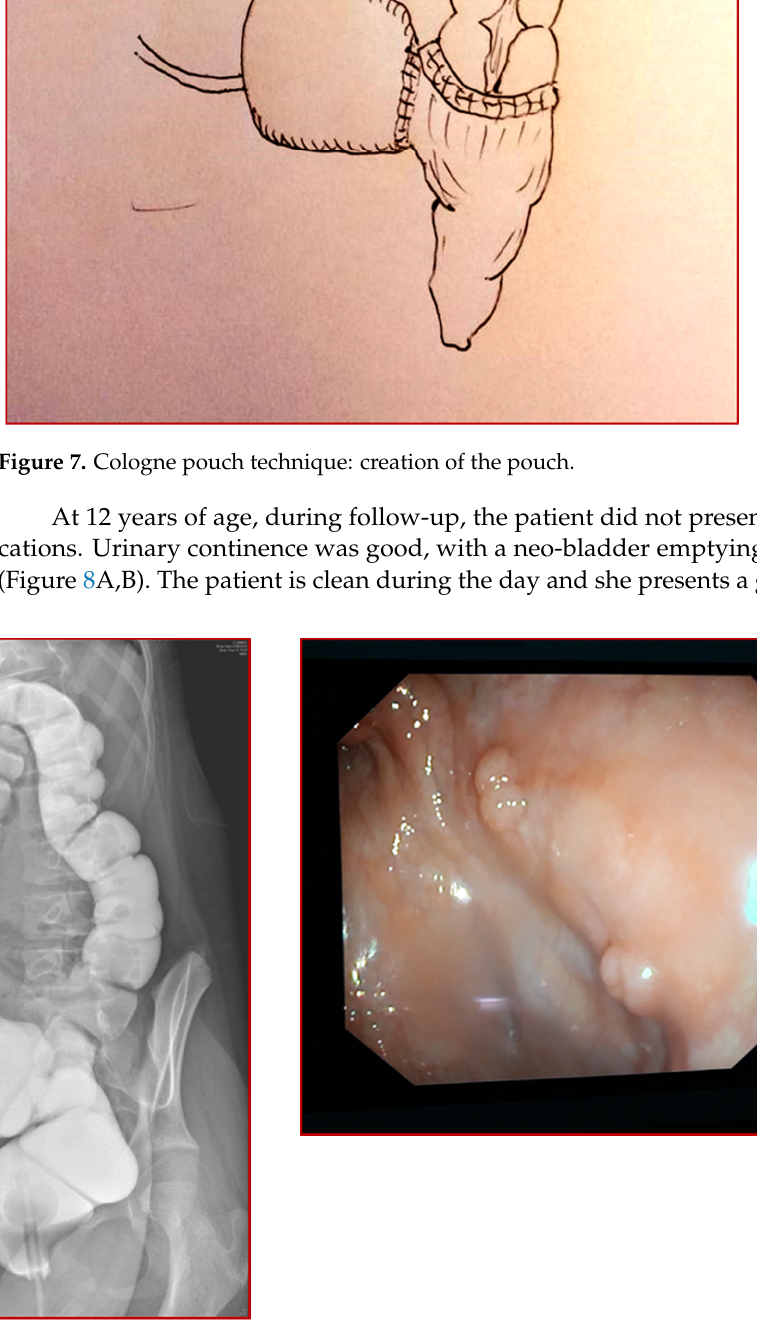
Figure 6. Cologne pouch technique: reimplantation of the ureters with an antirefluxive technique.